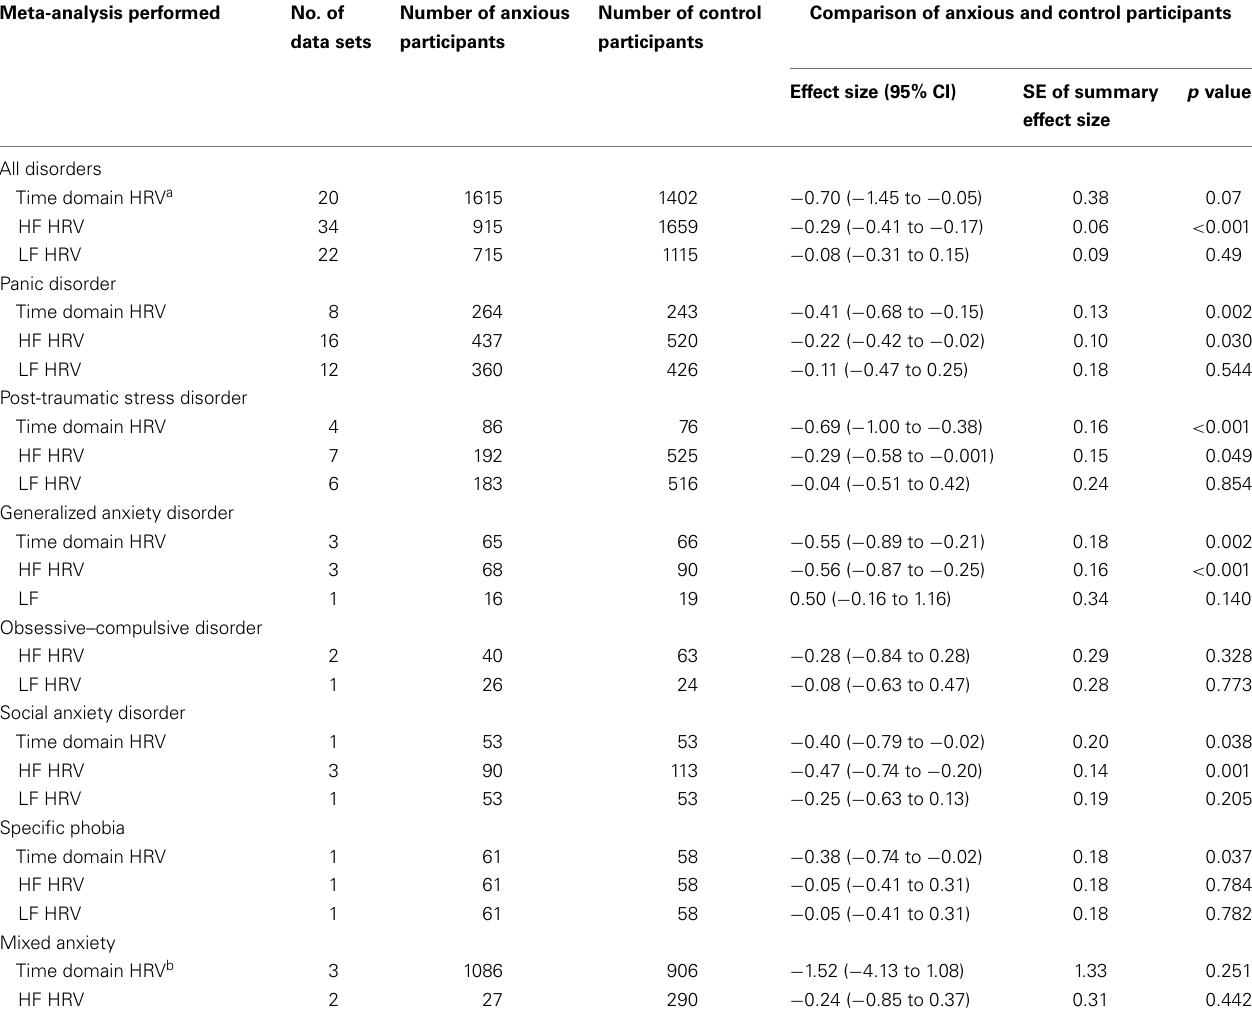
Table 2 | Meta-analysis results of HRV in specific anxiety disorders